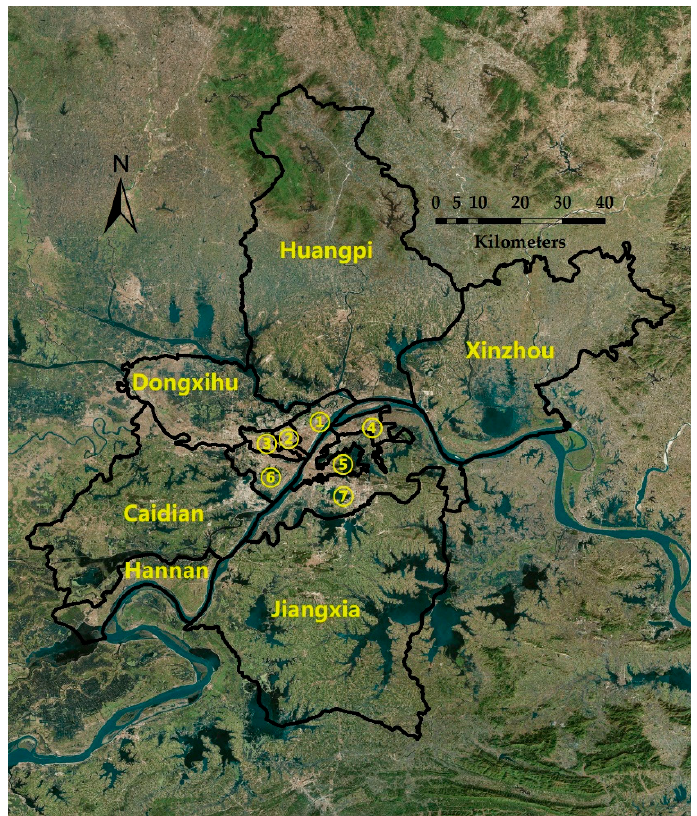
Figure 2. The range of the study area: Wuhan, China (The municipal districts are: ① Jiang’an, ② Jianghan, ③ Qiaokou, ④ Qingshan, ⑤ Wuchang, ⑥ Hanyang and ⑦ Hongshan).